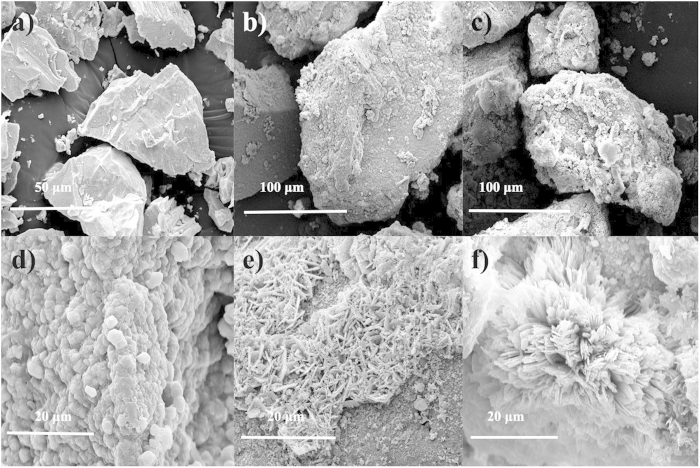
SEM images of (a) initial manganese power, (b,c) final manganese power, (d) ball-like MnOx, (e) rod-like MnOx, (f) flower-like MnOx.